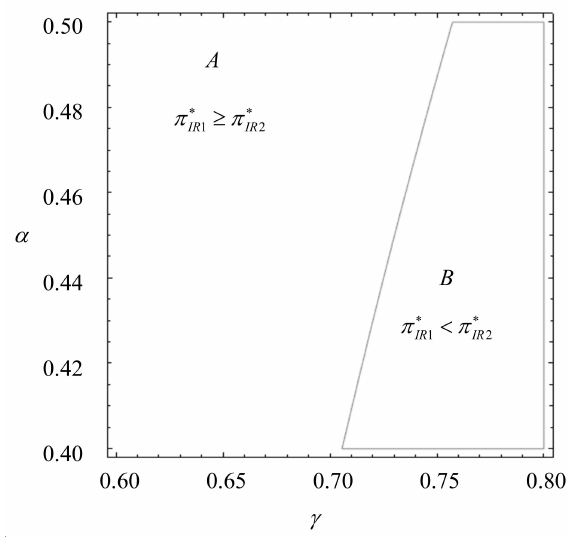
Figure 6. Impact of α and γ on the IR’s